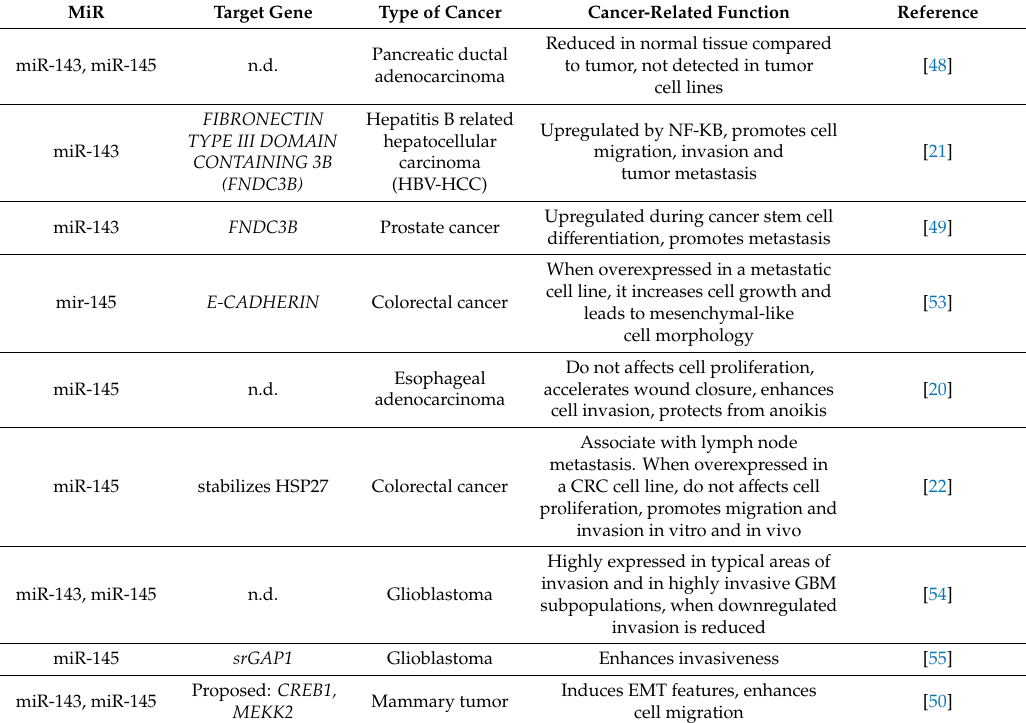
Table 1. Pro-tumorigenic functions of microRNA-143 / 145